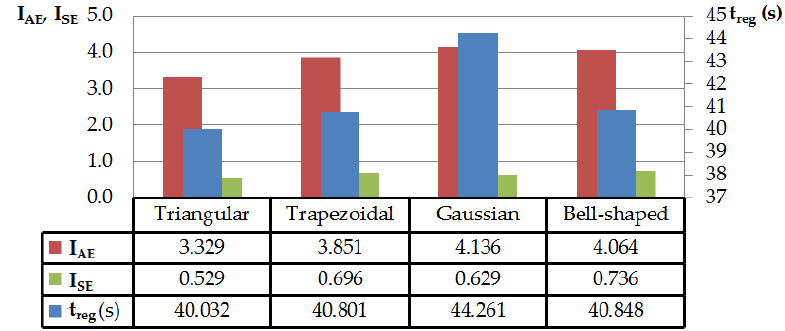
Figure 6. Effect of membership functions type on control criterions.